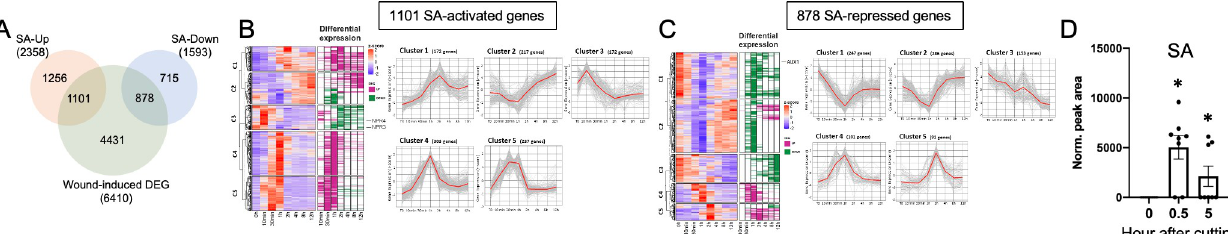
Fig 2. SA response was activated after wounding. (A) Venn diagram showing the overlap of genes that were differentially expressed upon wounding in the first 12 hours after cutting [8] and markers of the SA response [32]. The SA-induced genes are shown in the light pink circle, SA-repressed genes are shown in the light blue circle, and in the green circle are genes that showed altered expression upon wounding in at least one time-point of the experiment. A total of 1101 genes are activated by SA and differentially expressed upon wounding. Furthermore, 878 of the SA-repressed genes are differentially expressed in wounded leaves. (B) Expression profile of the 1101 SA-activated genes that were differentially expressed in leaves during DNRR Marker genes of the SA response were defined by the treatment of Arabidopsis seedlings with exogenous SA [32]. Genes activated by SA and differentially expressed in our experiment were submitted to hierarchical clustering based on their expression profile in wounded leaves. Differential expression at each time point is indicated with a color code (induced: purple; repressed: green). NPR4 and NPR3 are part of cluster 3 (C3) and are highlighted next to the heatmap. A representative profile of each cluster is shown on the right (red line: average behavior; grey line: individual genes). (C) Expression profile of the 878 SA- repressed genes that were differentially expressed in leaves during DNRR. Marker genes of the SA response were defined by the treatment of Arabidopsis seedlings with exogenous SA [32]. Genes repressed by SA and differentially expressed in our experiment were submitted to hierarchical clustering based on their expression profile in wounded leaves. Differential expression at each time point is indicated with a color code (induced: purple; repressed: green). AUX1 is part of cluster 1 (C1) and is highlighted next to the heatmap. A representative profile of each cluster is shown on the right (red line: average behavior; grey line: individual genes). (D) Accumulation of free SA in explants. Each dot represents an independent SA-measurement from two leaf explants by LC-MS (n = 8). The Y axis is peak area normalized for loading based on internal